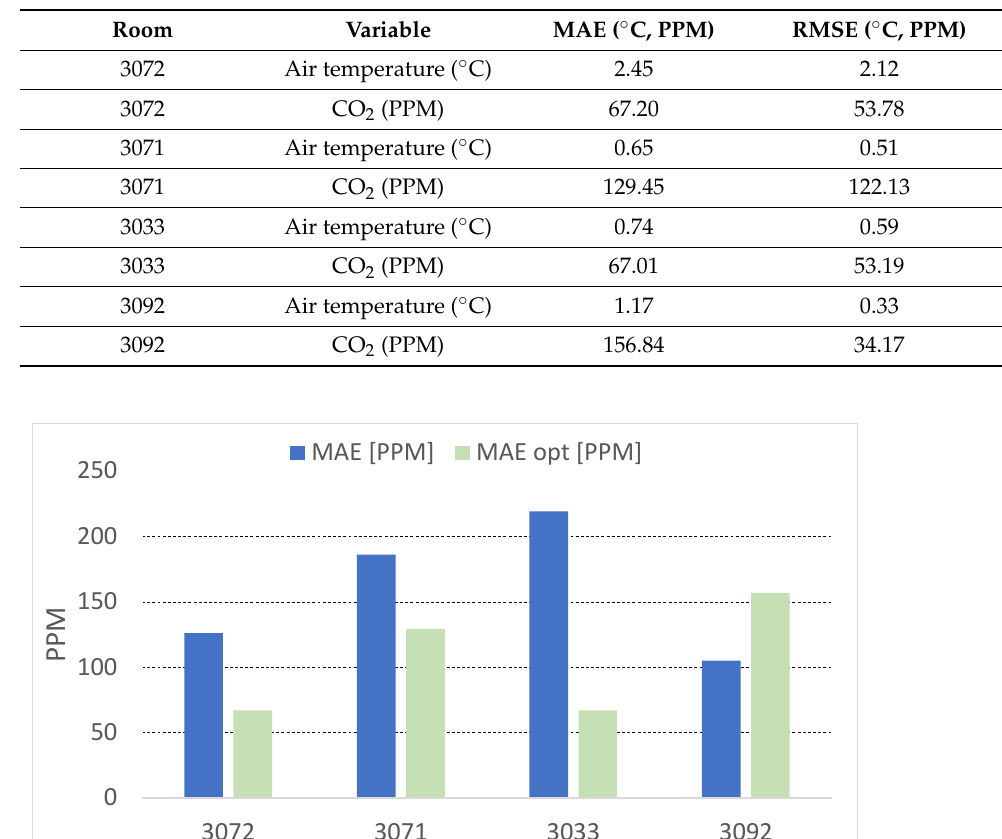
Table 3. Calibration metrics after fine-tuning with optimisation for various rooms of the Helios building for the period January–March 2018.